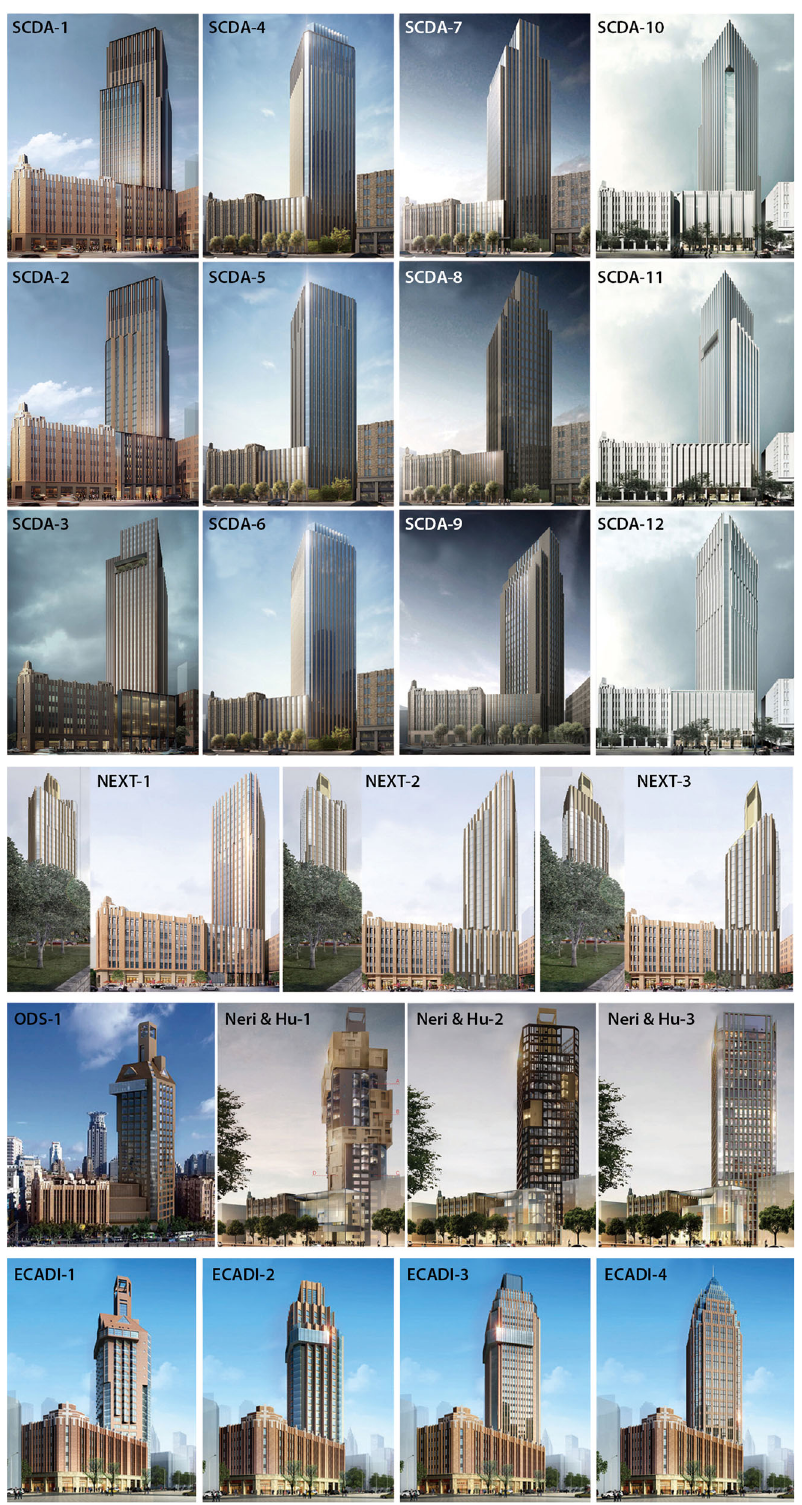
Fig. 10 Renovation proposals for the SECEP Building (Source: Images provided by